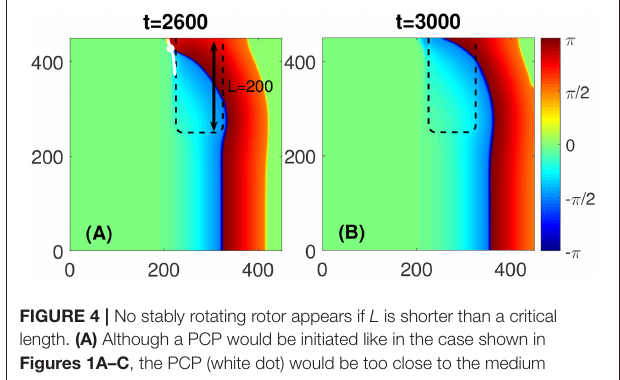
FIGURE 4 | No stably rotating rotor appears if L is shorter than a critical length. (A) Although a PCP would be initiated like in the case shown in Figures 1A–C , the PCP (white dot) would be too close to the medium boundary and vanishes eventually, as shown by its trajectory (white line). (B) After the PCP vanishing the curved wave would propagate to the right boundary of the medium, and no stably rotating rotor would exist. The FPR length L 200 and other parameters are the same as in Figure 1 . =